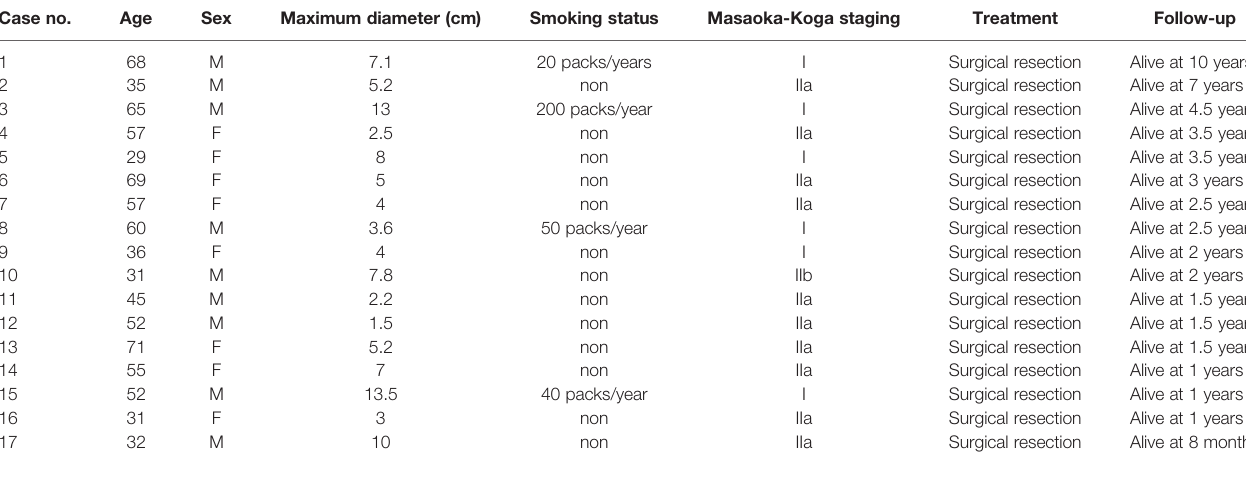
TABLE 1 | Clinical information of 17 cases of metaplastic thymoma in this study. Case